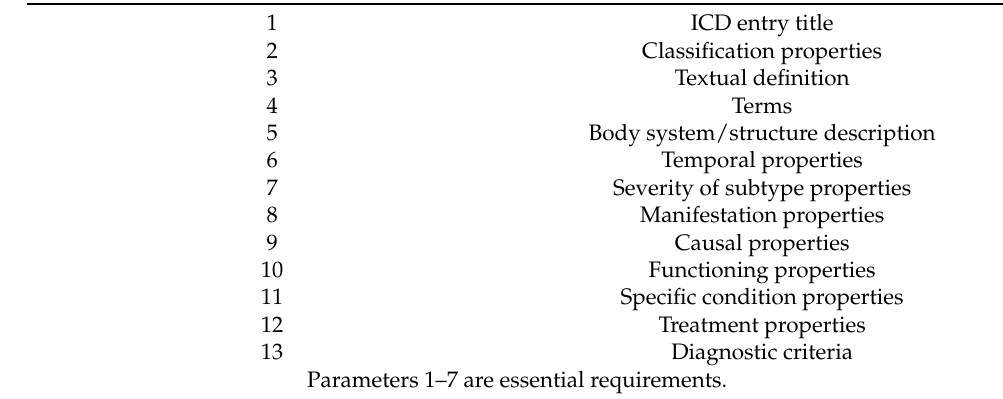
Table 2. List of fields of the ICD-11 content model.